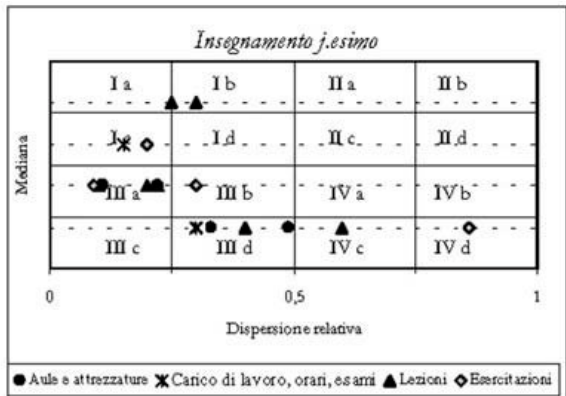
Figura 5a – Suddivisione dell’area del grafico in V = 16 sotto quadranti ( prima ipotesi ). La variabilità ha un peso maggiore nella differenziazione qualitativa tra sotto-quadranti.